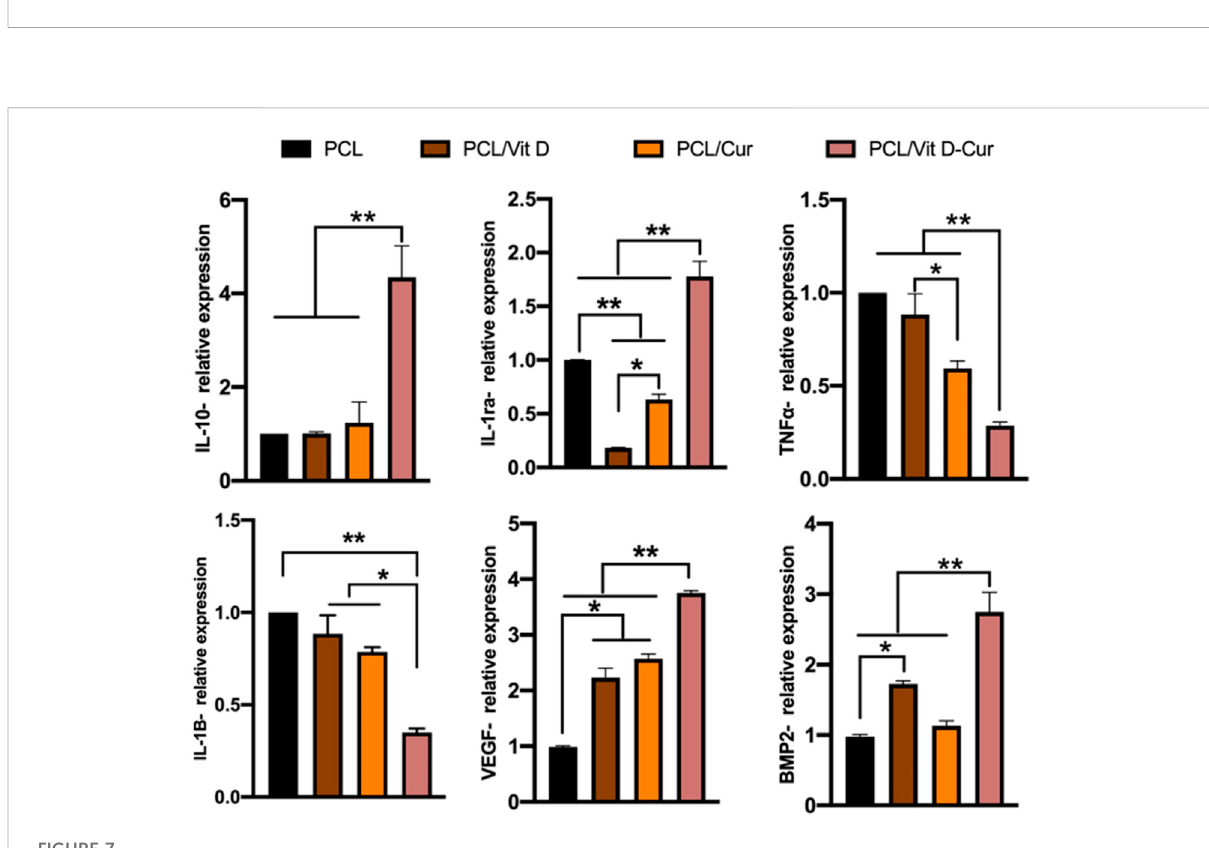
Frontiers in Bioengineering and